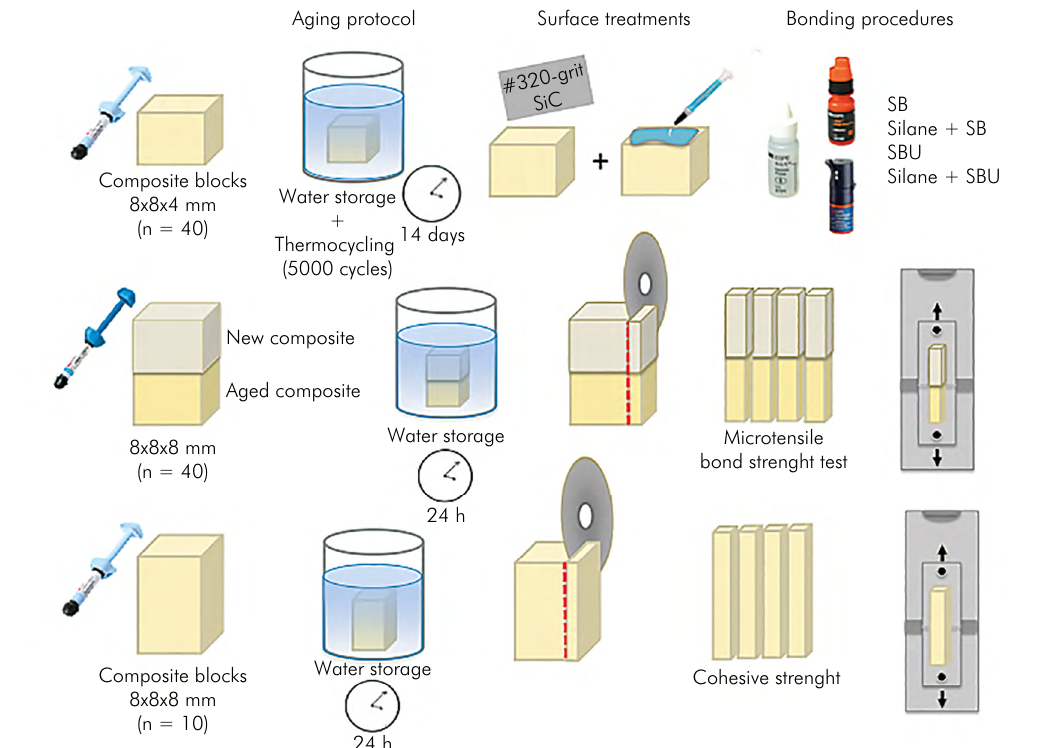
Figure. Experimental design of the